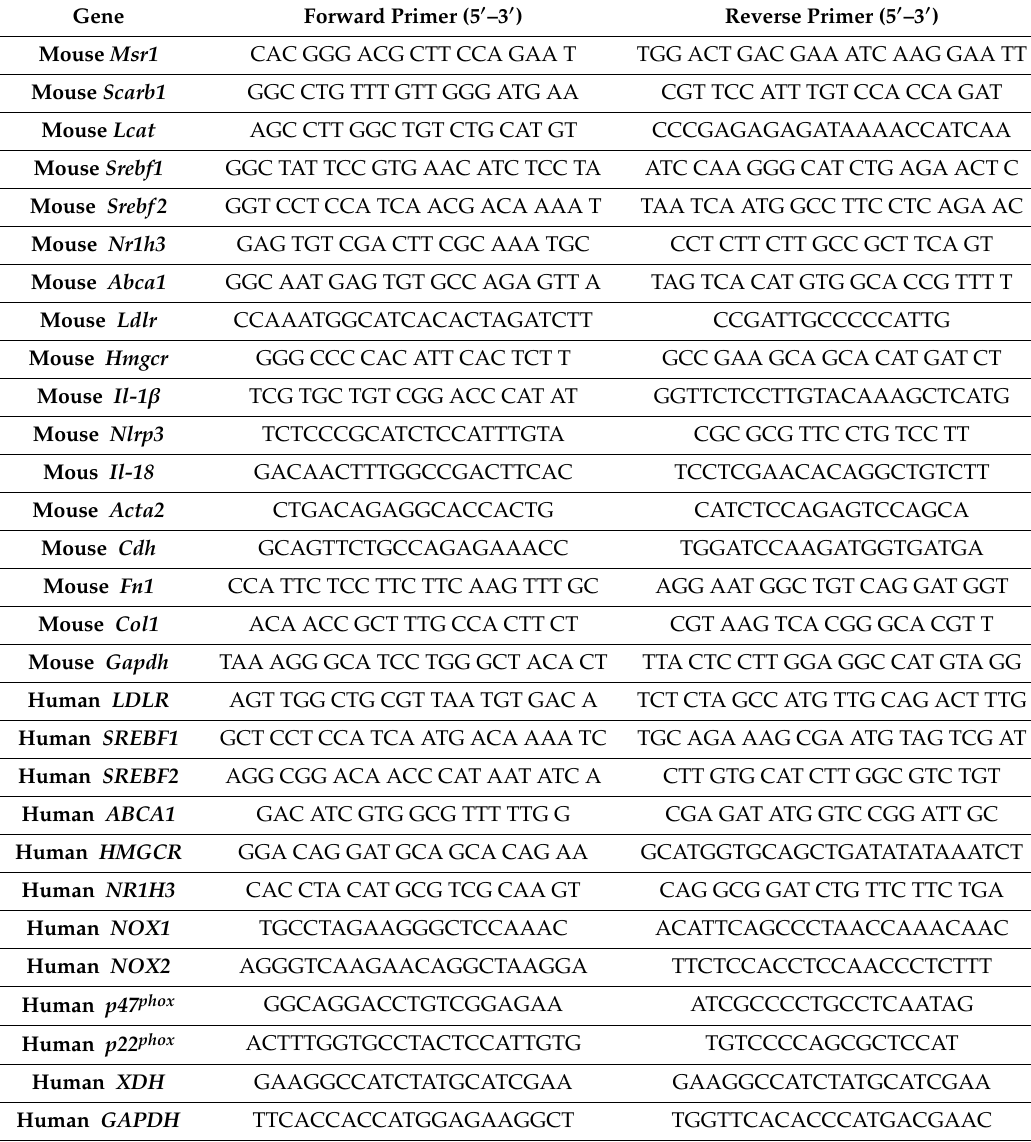
Table 1. Oligonucleotide primer